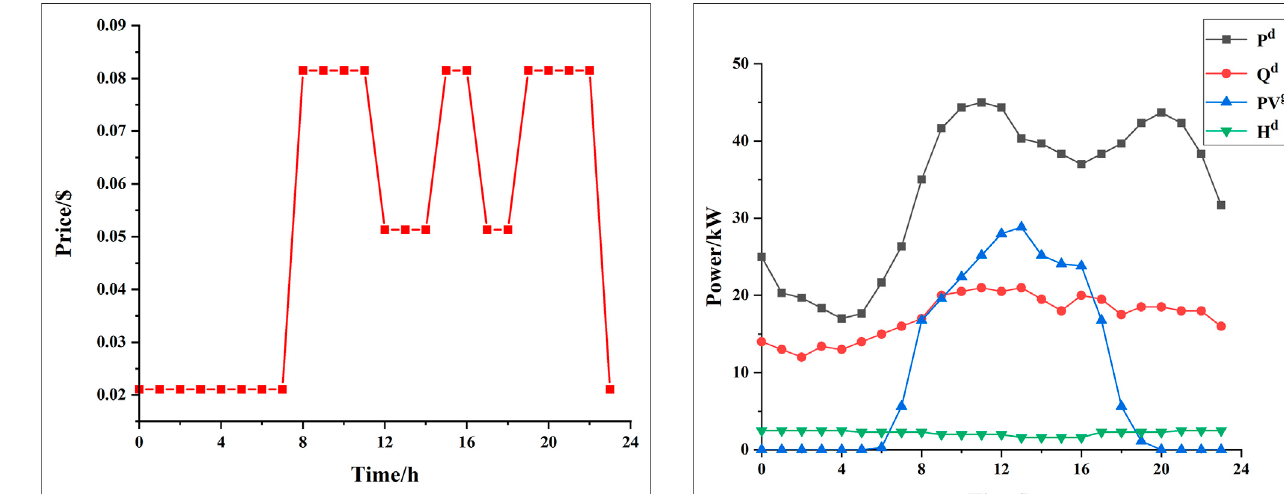
FIGURE 6 | Power and heat demand and solar